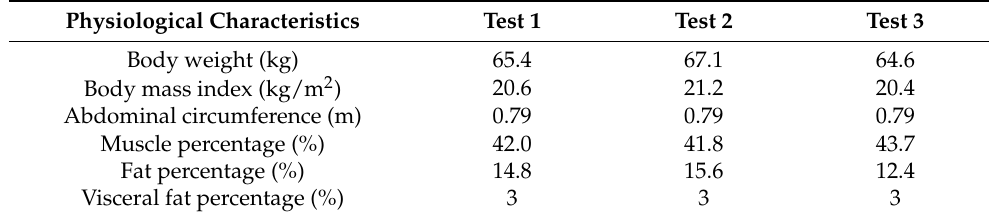
Table 1. Subject’s body measurements at the start of each study. Physiological